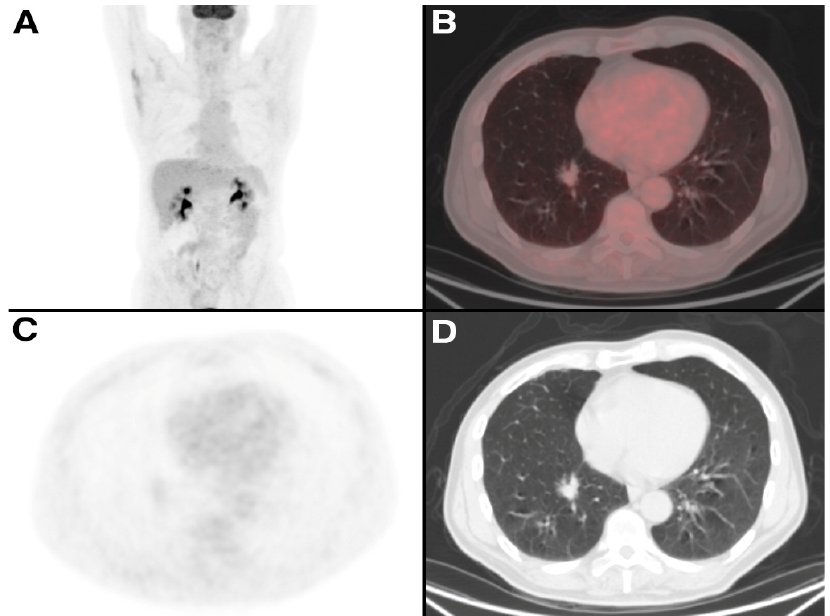
Figure 4. A 78-year-old man treated 7 years earlier with enucleation for RCC, underwent a ceCT scan which showed an irregular lung mass in the right lower lobe. [ 18 F]FDG PET/CT was also performed and showed no uptake of the tracer in the lung nodule. Two months later, he underwent lobectomy with histological examination of the surgical specimens, which confirmed that the lung nodule was an adenocarcinoma. ( A ) Maximum Intensity Projection (MIP) image of [ 18 F]FDG PET/CT ( B – D ) PET/CT fusion image, PET and CT images of [ 18 F]FDG PET/CT.